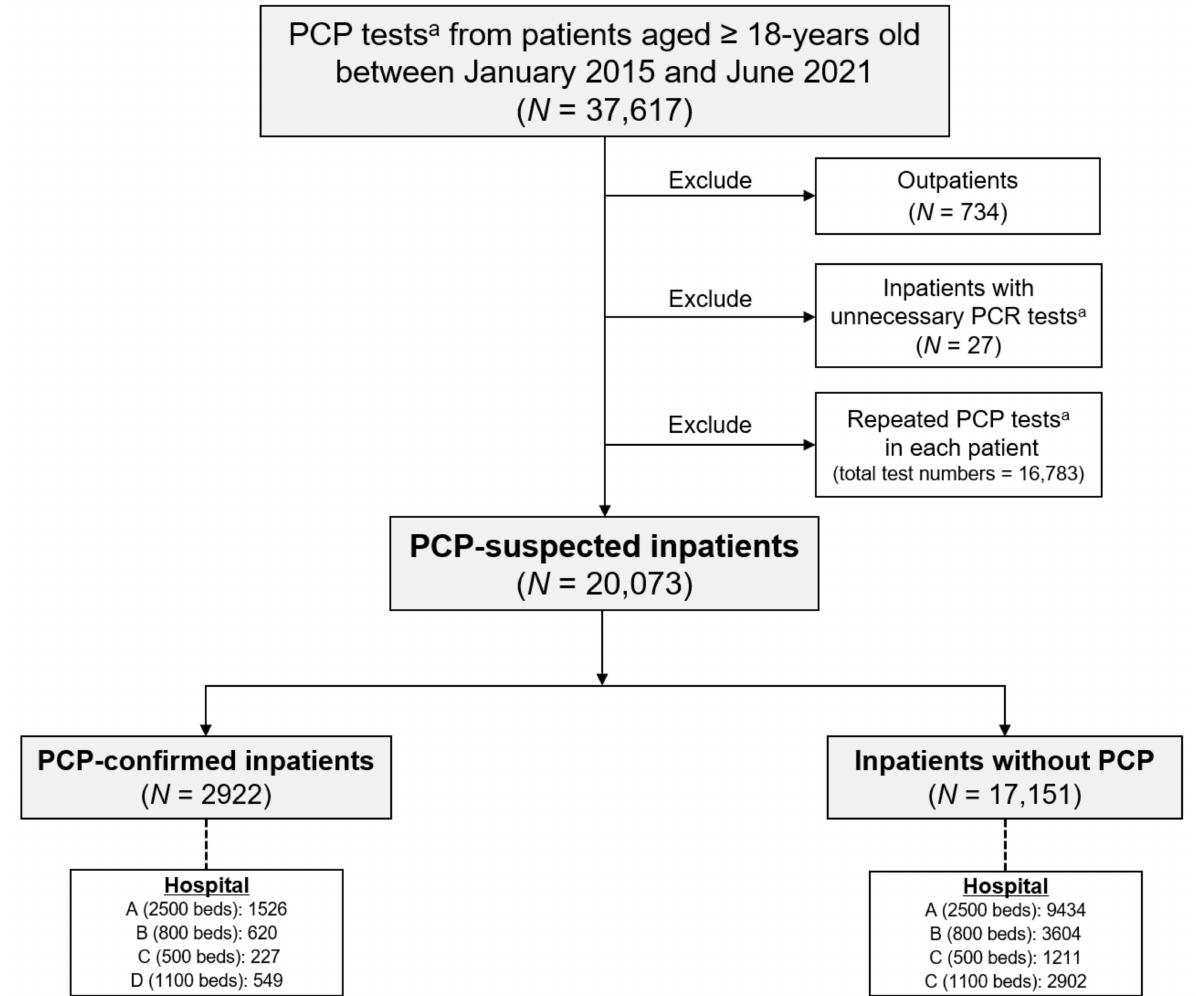
Figure 1. Schematic presentation to select the PCP-suspected and -confirmed inpatients. PCP tests a include PCR and cytology in the sputum, bronchial washing, and BAL fluid, as well as histopathology in lung or bronchial tissue. A, B, C, and D indicate the Severance, Gangnam Severance, Yongin Severance, and Anam hospitals, respectively. Abbreviations: BAL, bronchoalveolar lavage; PCP, P. jirovecii pneumonia; PCR, polymerase chain